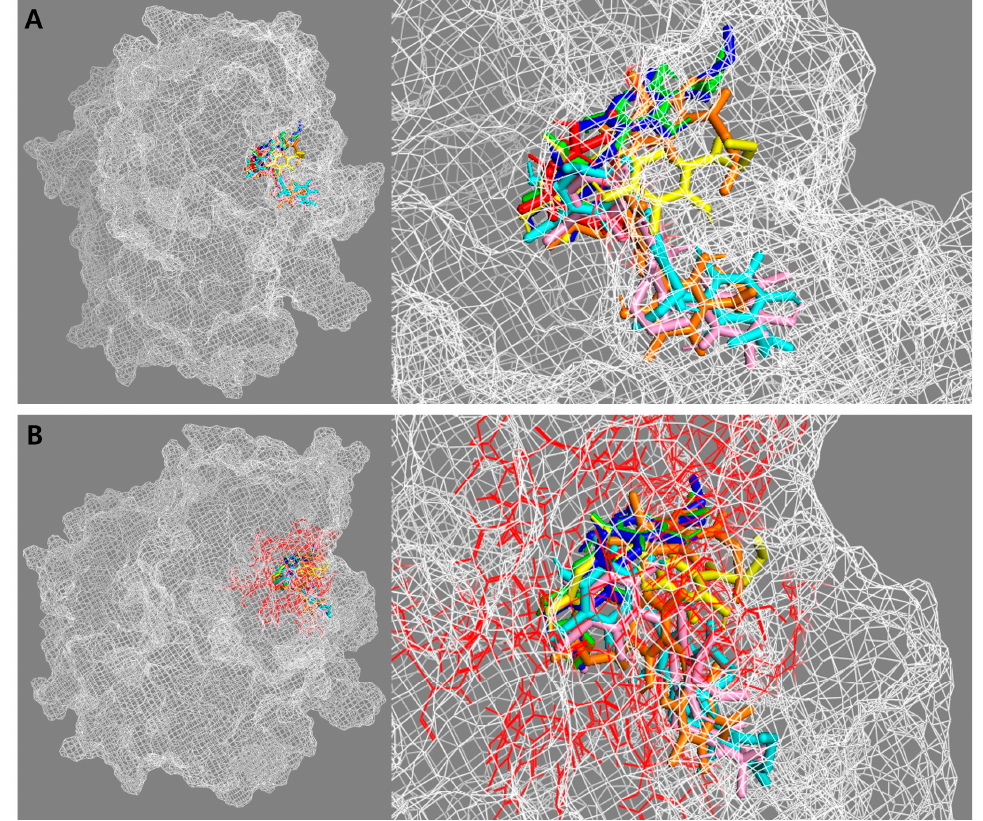
Figure 5. The docking results of the substrate and active compounds 13 – 15 and 26 – 28 (( A ) substrate: red, compounds 13 : green, 14 : blue, 15 : yellow, 26 : pink, 27 : cyan, and 28 : orange) and the active site of the β -glucuronidase enzyme (( B ) red site).